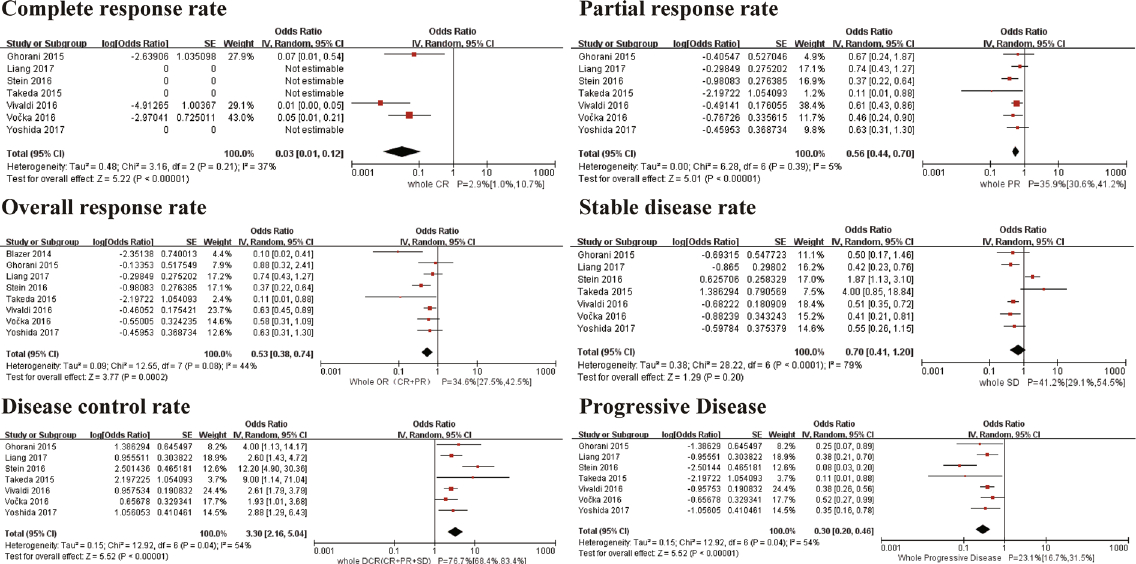
Figure 3. Meta-analysis for objective response rate. SE: standard error. IV: random-model generic inverse variance method. 95% CI: 95% confidence